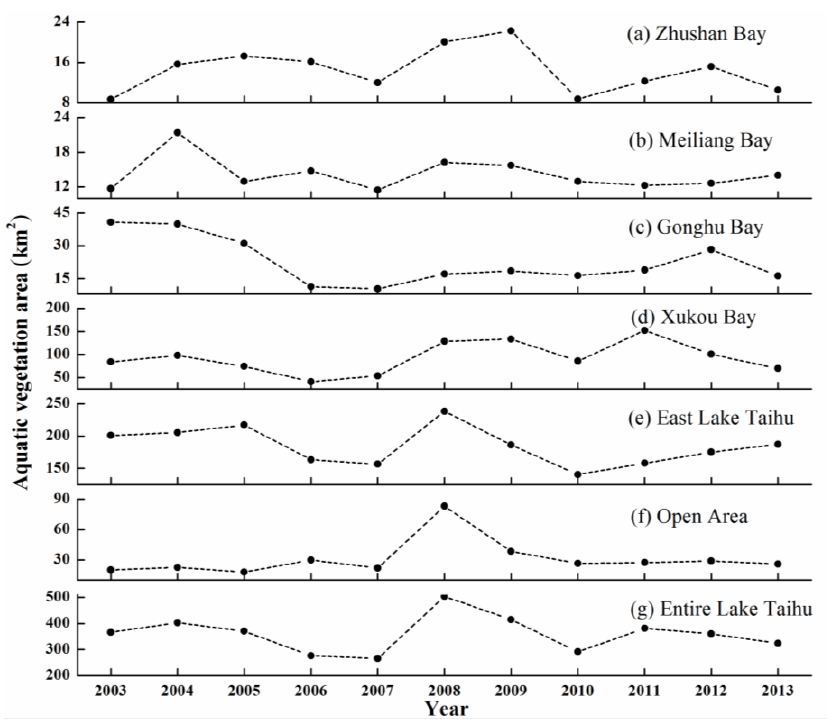
Figure 8. Satellite-derived areas of aquatic vegetation area: ( a ) Zhushan Bay, ( b ) Meiliang Bay, ( c ) Gonghu Bay, ( d ) Xukou Bay, ( e ) East Lake Taihu, ( f ) Open Area and ( g ) Entire Lake